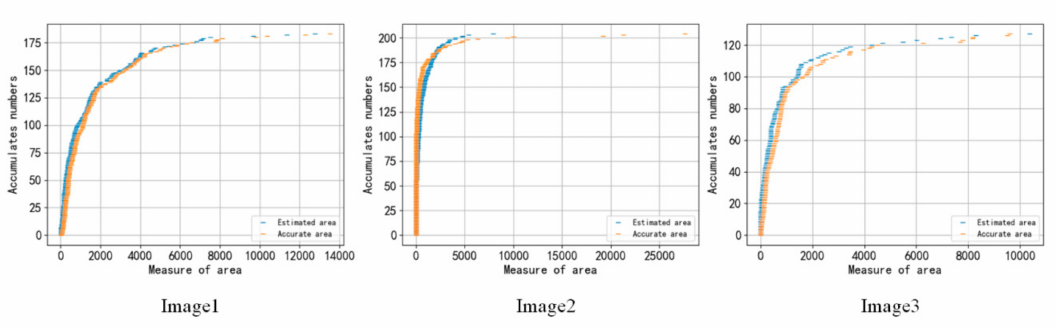
Figure 13. Cumulative size distribution of three test